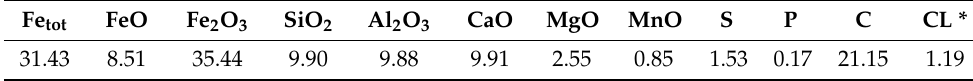
Table 1. Chemical composition of sintering sludge, [%].